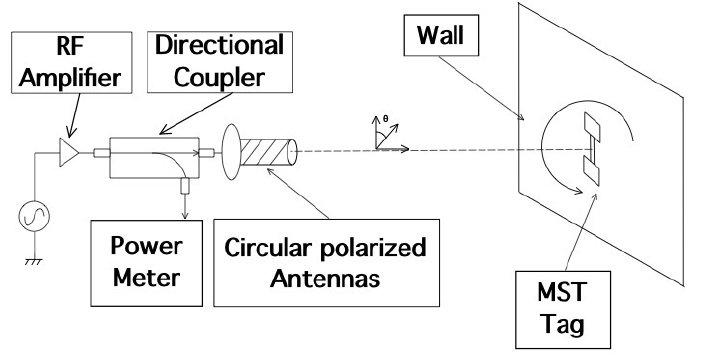
Figure 10. Assessment of the tag received signal vs. tag orientation. Experimental set-up.